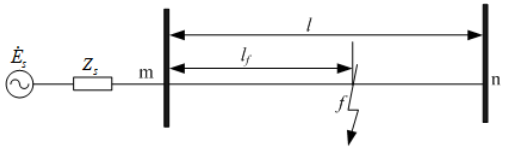
Figure 1. The faulted traction network system.